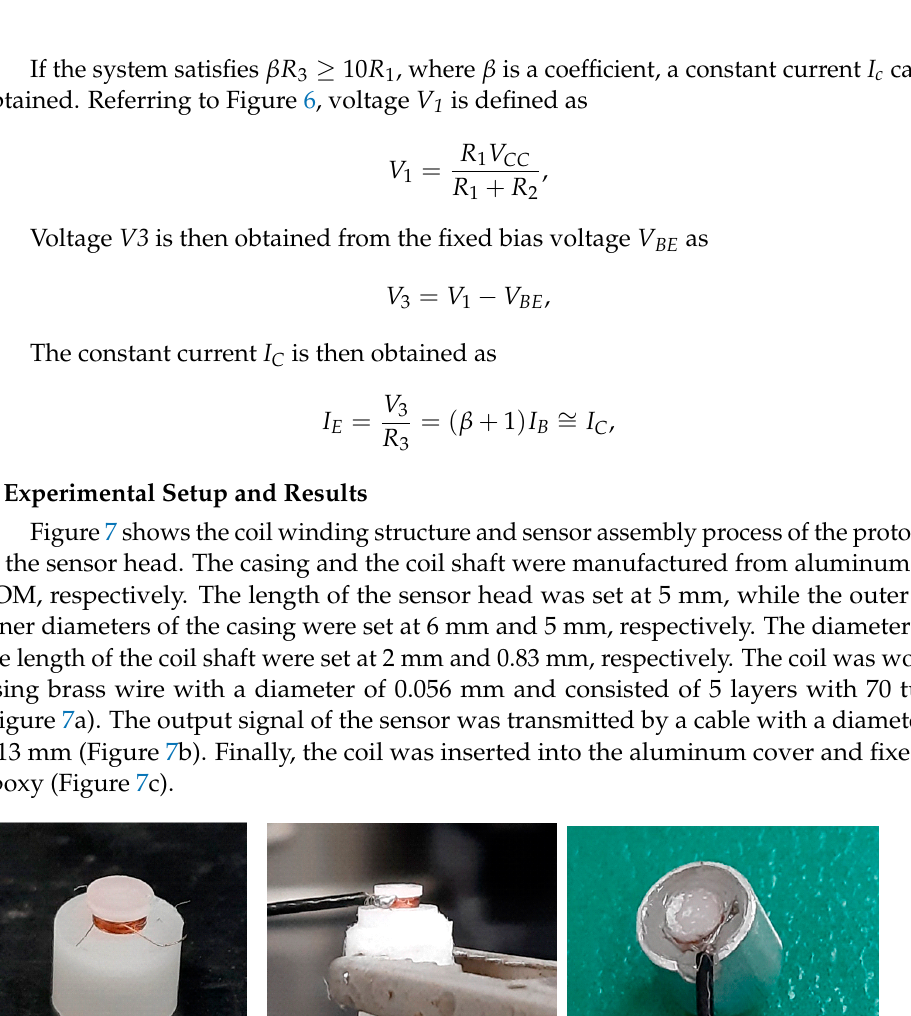
Figure 6. Constant-current circuit diagram.